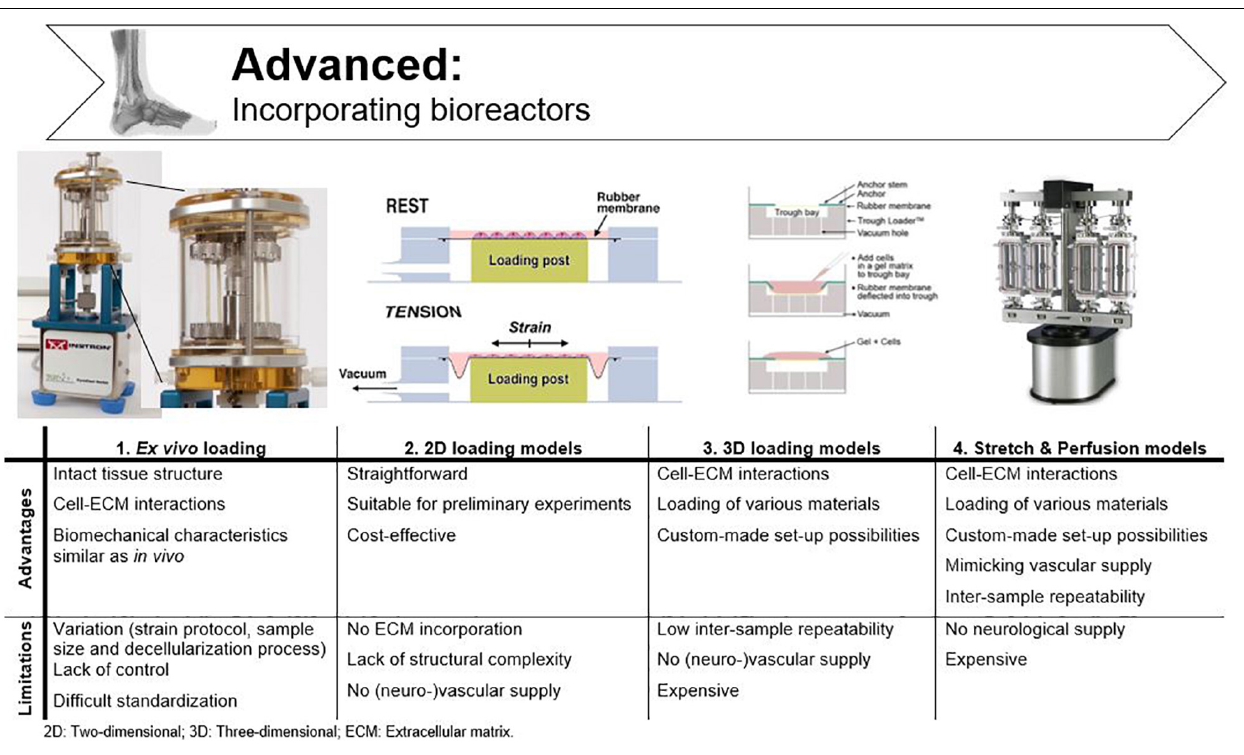
FIGURE 6 | Advantages and disadvantages of bioreactors used in tendon tissue engineering. Adjusted from Ligagen R (cid:13) L30–4C (DynaGen systems; Dartmouth, NS, Canada), BioFlex R (cid:13) culture plates and TissueTrain R (cid:13) (Flexcell International; Hillsborough, NC, United States), and BOSE BioDynamic R (cid:13) 5,200 multi-chamber (TA Instruments; New Castle, United